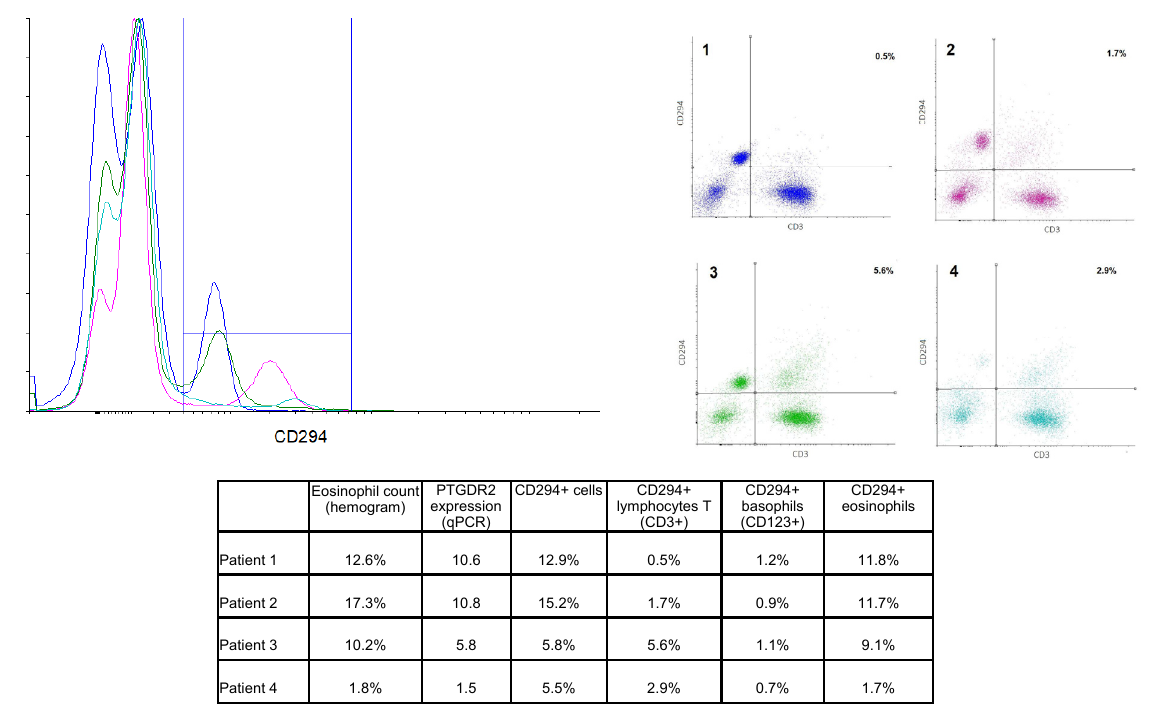
Figure 4. Overlay histogram and dot plots from 4 selected patients. Left panel: Overlay histogram showing CD294+ cells in all 4 patients. Right panel: Dot plot of CD3-CD294 labeling, percentages of the right upper quadrant (CD3+CD294+ cells) are shown. Color code was kept in both graphs. Lower table: Percentage of the different CD294+ cell population in comparison to eosinophil counts and PTGDR2 expression for the selected four patients.